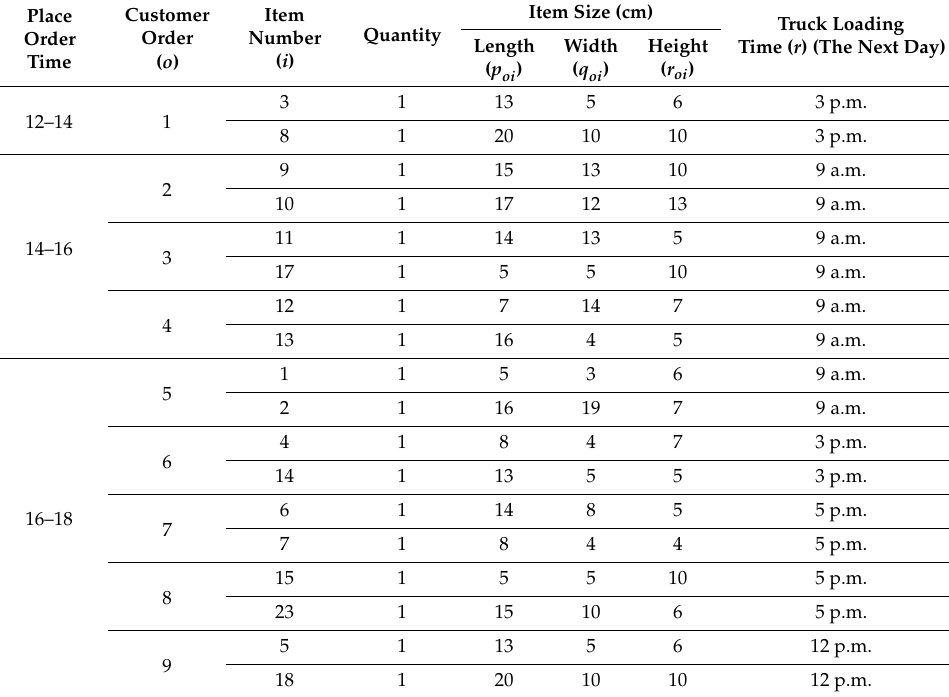
Table 4. The customer orders.